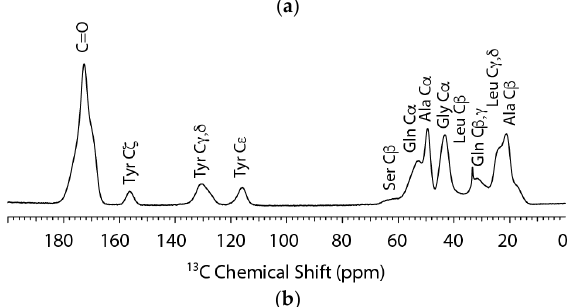
Figure 1. ( a ) Consensus primary amino acid sequence for N. clavipes MaSp1. Gly-Gly-X regions where X = A, Y, L and Q are indicated in green, orange, red, and blue; and ( b ) 1 H → 13 C cross polarization magic angle spinning (CP-MAS) NMR spectrum of 13 C-labeled N. clavipes dragline silk. Table 1. 13 C NMR isotropic chemical shifts in ppm from tetramethylsilane (TMS) for N. clavipes dragline silk, random coil, and polypeptides with defined secondary structures. Residue N. clavipes α -Helix β -Sheet Random Coil Gly C